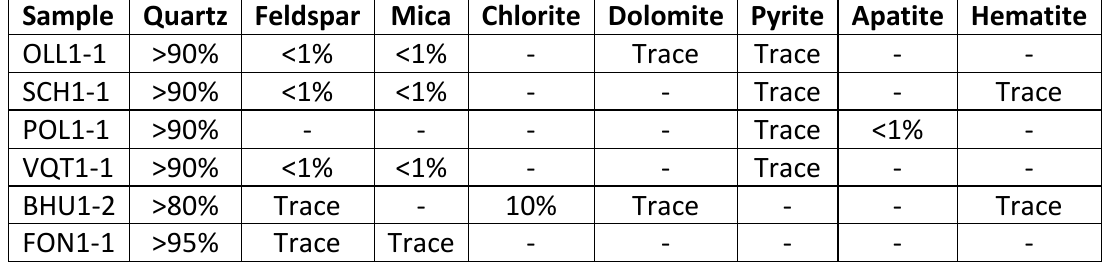
Table 3: Major, minor and trace elements in XRD. Sample